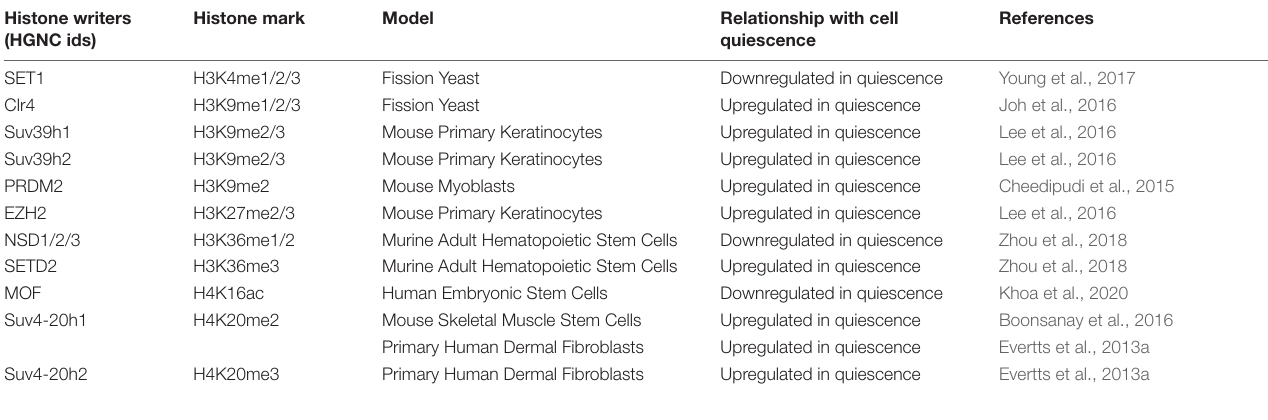
TABLE 4 | The relationship of histone writers with